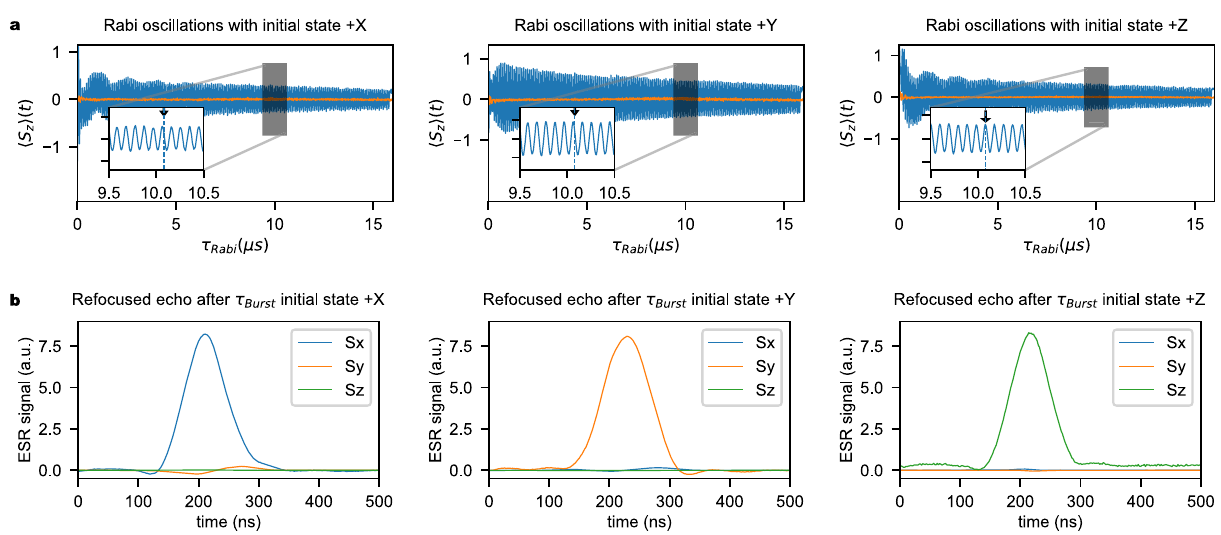
Figure 5. CaWO 4 :Gd 3 + . ( a ) Rabi oscillations shown as the real and imaginary part of the recorded signal (blue and orange lines, respectively). From left to right, the initial (and final) state of the spin are After a time given by an integer number of Rabi flops, shown with an arrow in the inset, ( b ) the spin-echo signal is recorded for each spin component, using the measurement sequence described in Fig.